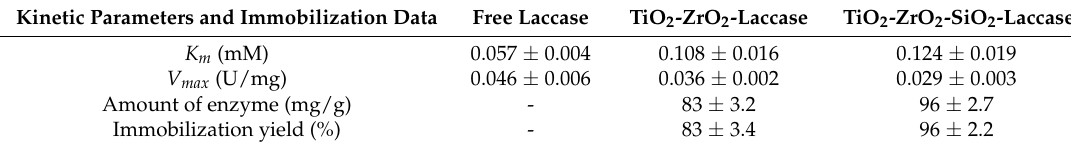
Table 1. Kinetic parameters of free and immobilized enzyme, amount of immobilized enzyme, and immobilization yield.